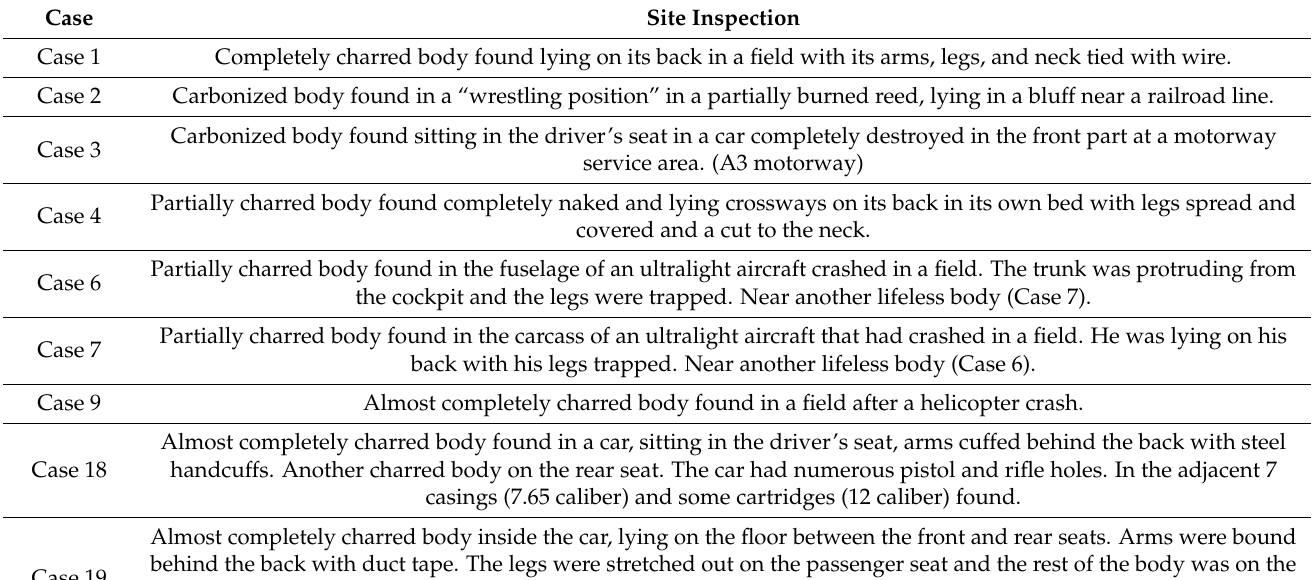
Table 2. The table summarizes the results of the forensic medical examination in 22 cases, along with the location where the body was found. Case 6 and case 7 are two bodies found at the same location, so the same forensic examination was